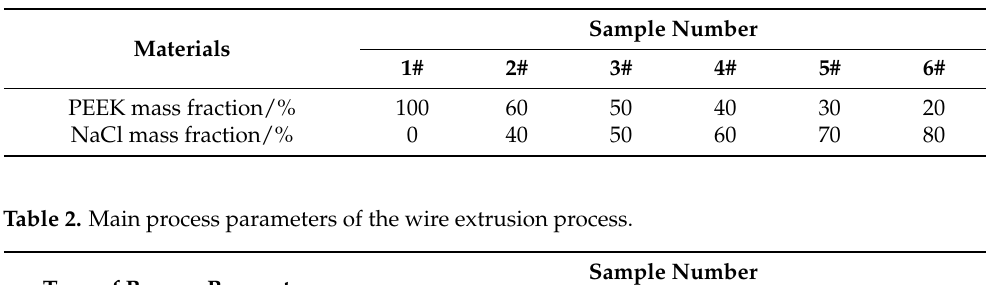
Table 1. NaCl/PEEK material composition.